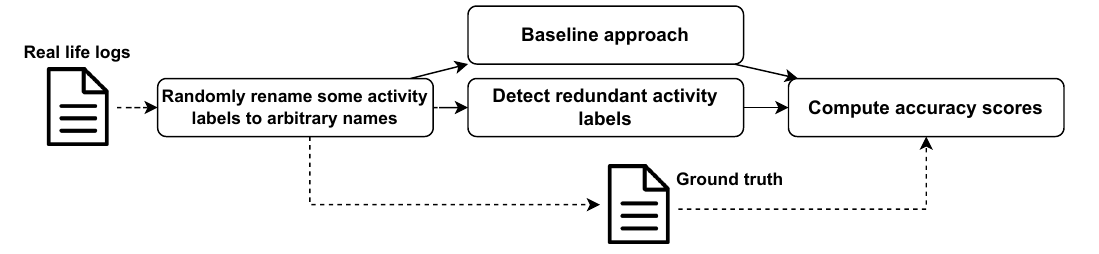
Figure 5. Overview of the evaluation